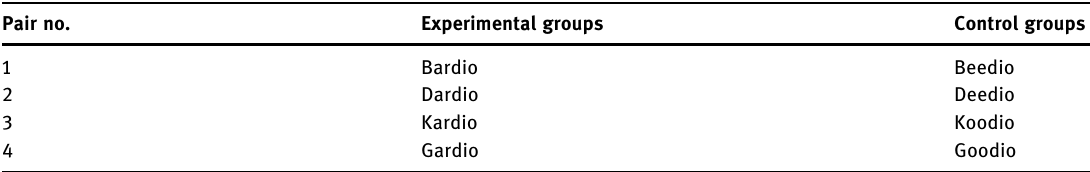
Table 8: Stimuli in the “ Low Vowels ” condition Pair